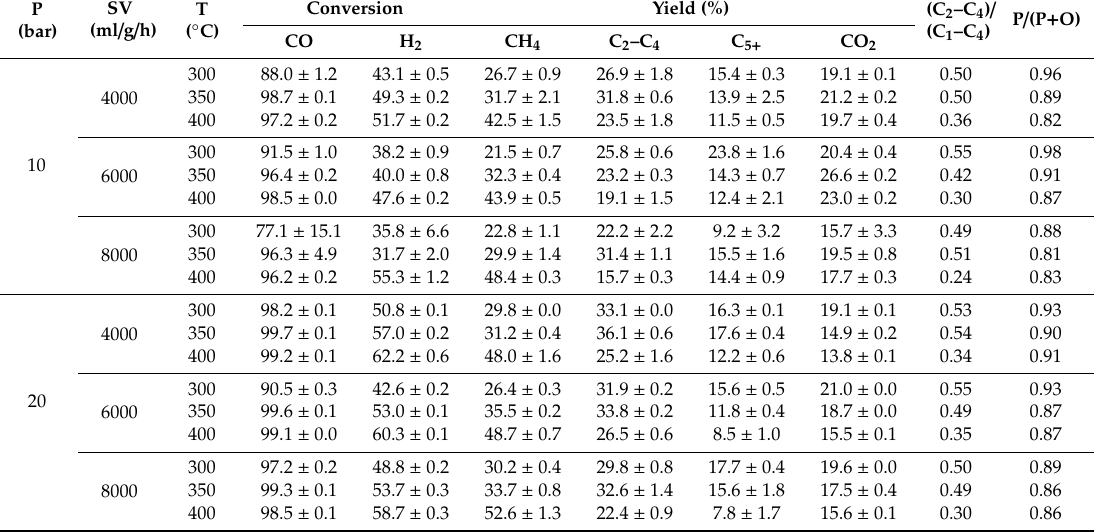
Figure 3. The initial CO conversion of the FT catalyst (5Co-15Fe / γ -Al 2 O 3 ) under ( a ) 10 and ( b ) 20 bar at di ff erent space velocities as a function of reaction temperature. Table 2. Summarization of catalytic performance over FT catalyst (5Co-15Fe / γ -Al 2 O 3 ) at di ff erent space velocity, reaction pressure and